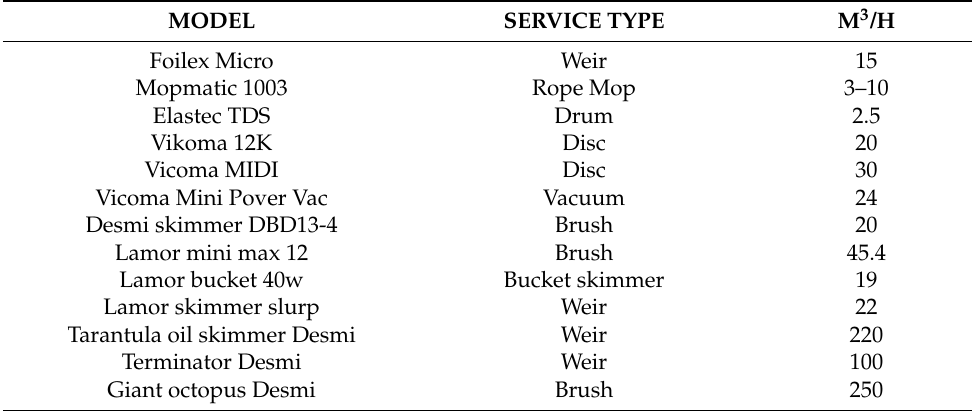
Table 1. Types of skimmers